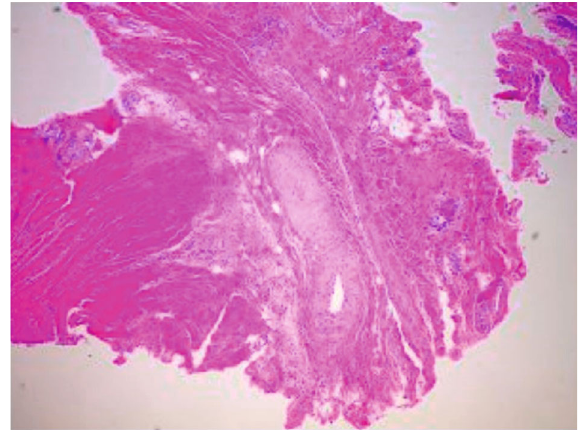
Figure 2: Microscopic image showing denuded cyst lining with focal synovium present. Gross specimen size 4 : 0 × 1 : 3 × 0 : 5